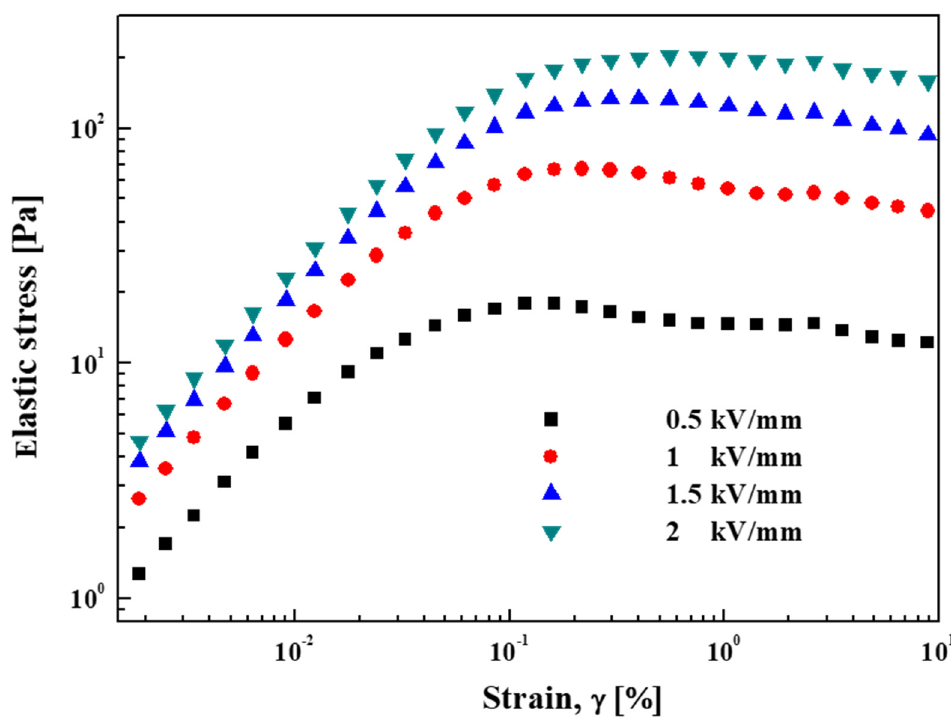
Figure 9. Elastic stress of the core–shell Fe 3 O 4 /POA particle (10 vol%)-based ER suspension as a function of strain.